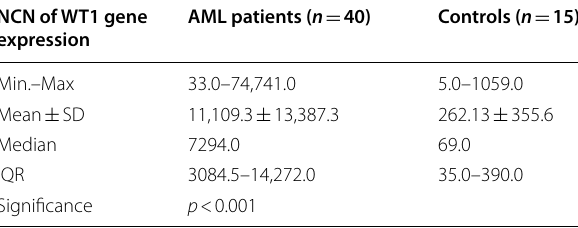
p : p value for Mann Whitney test for comparing Group I and group II Statistically significant at p